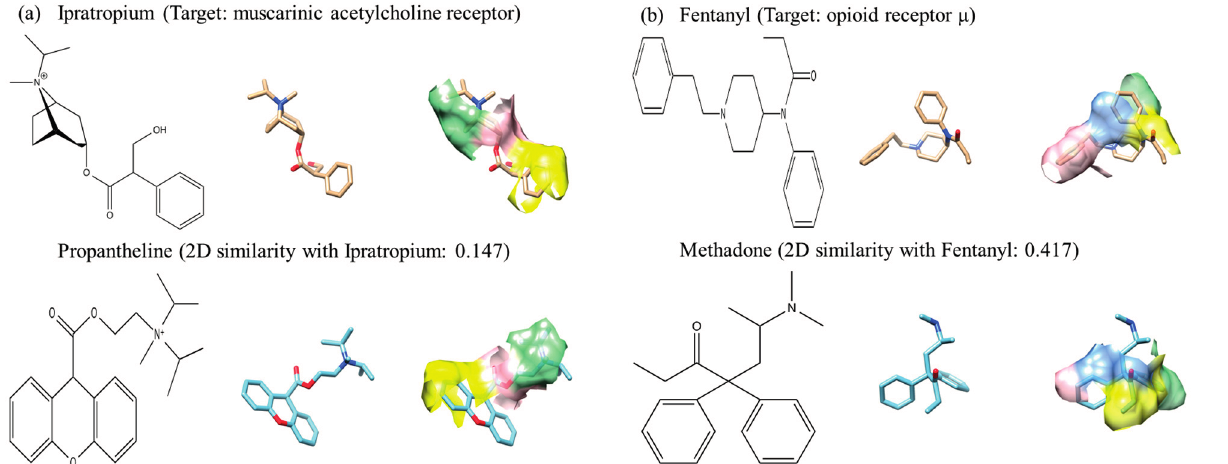
Figure 4. 2D and 3D structures of active compounds that PS ranked high relative to other programs. Fifty conformations were generated for each compound. ( a ) The template compound is ipratropium and the query compound is propantheline. PS, USR, GZD, and ROCS ranked the query compound as third, 92nd, 86th, and 122nd, respectively; ( b ) The template compound is fentanyl and query compound is methadone. The rankings from all programs are fifth, 127th, 66th, and 168th for PS, USR, GZD, and ROCS, respectively. Template and query compounds are colored in gold and cyan, respectively. Matched pairs by PS have the same color